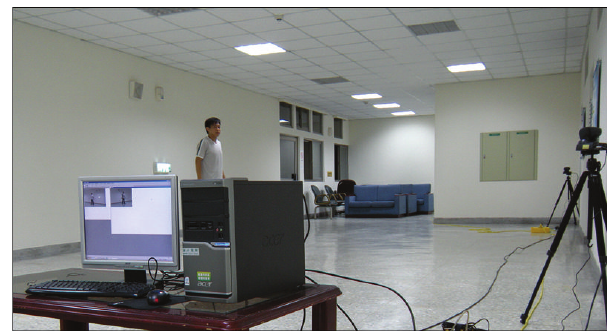
Figure 9: The environment for performing experiments, which shows the locations of the two cameras and the person performing different postures.